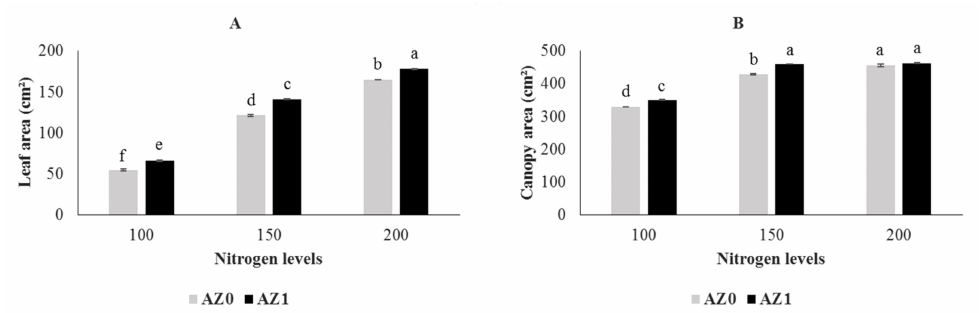
Figure 2. Leaf area ( A ) and canopy area ( B ) in hydroponically grown lettuce influenced by Azotobacter under different nitrogen levels. The letters indicate the mean comparison using LSD test ( p < 0.05) which was implemented for examining the differences among the